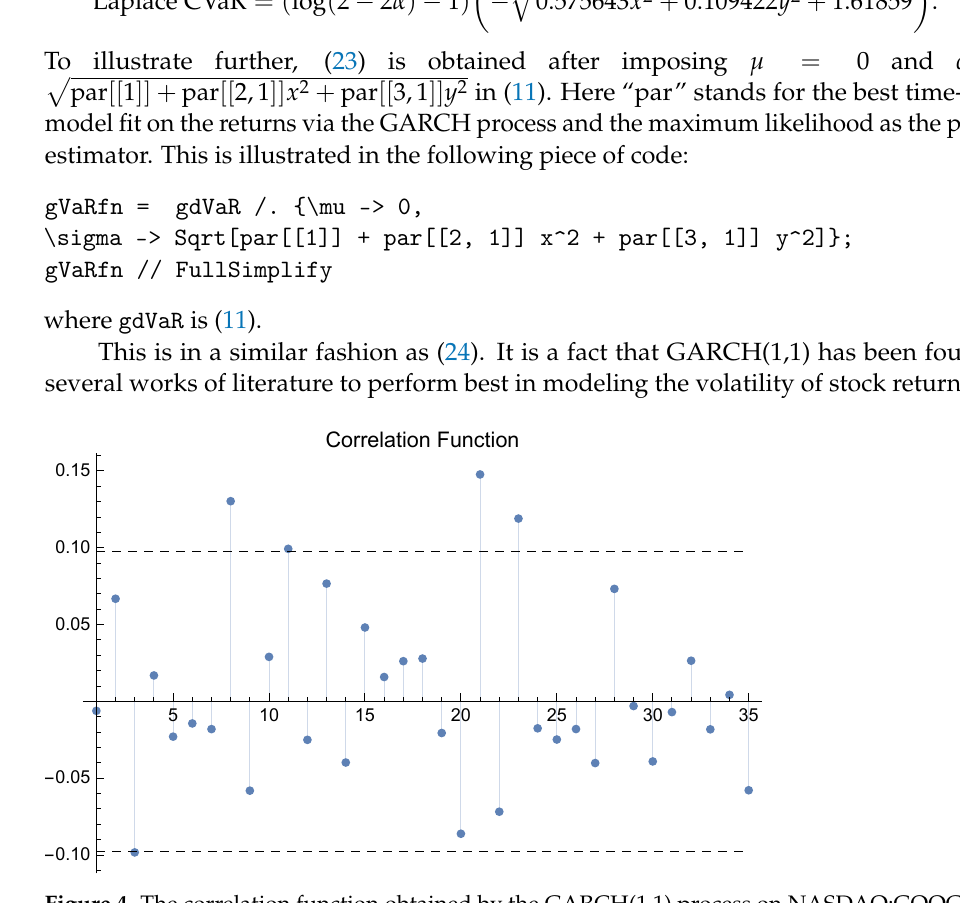
Figure 4. The correlation function obtained by the GARCH(1,1) process on NASDAQ:GOOG.